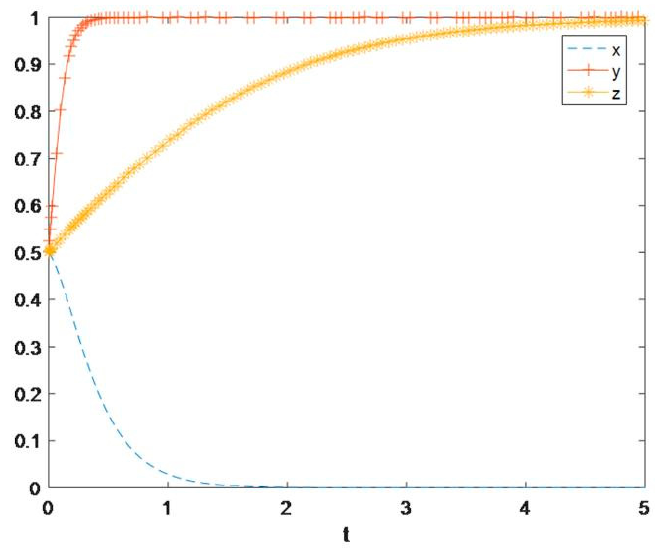
Figure 7. Two-dimensional diagram of evolutionary path at stable point (0, 1, 1).